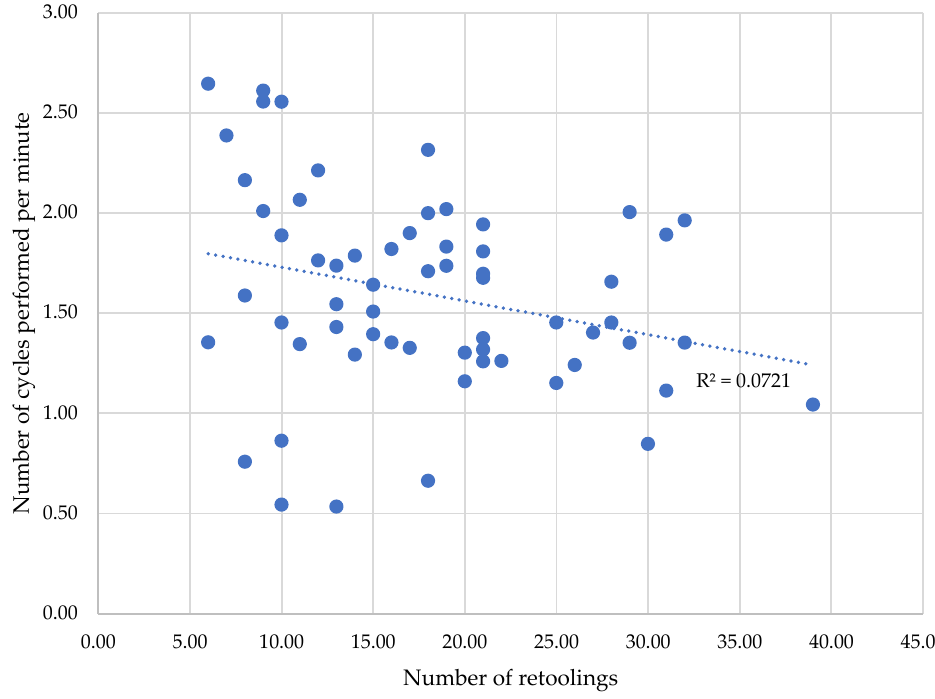
R² = 0.3111 R² = 0.3111